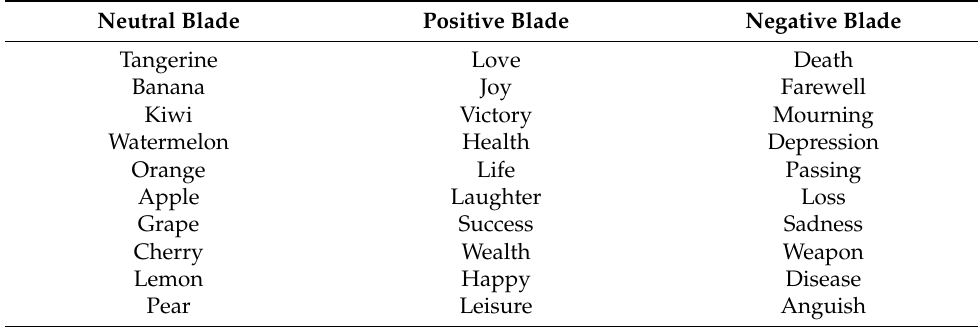
Table 3. Neutral, positive, and negative